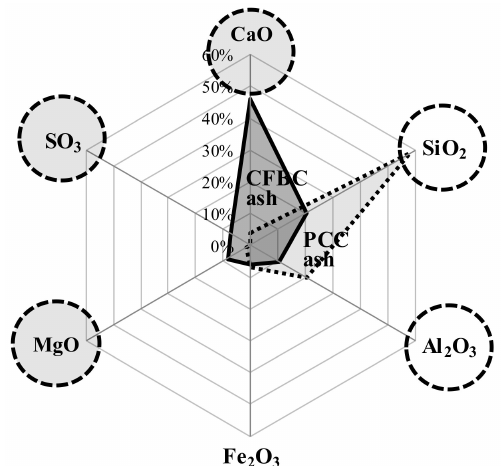
Figure 3. Chemical compositions of circulating fluidized bed combustion (CFBC) ash and pulverized coal combustion (PCC)